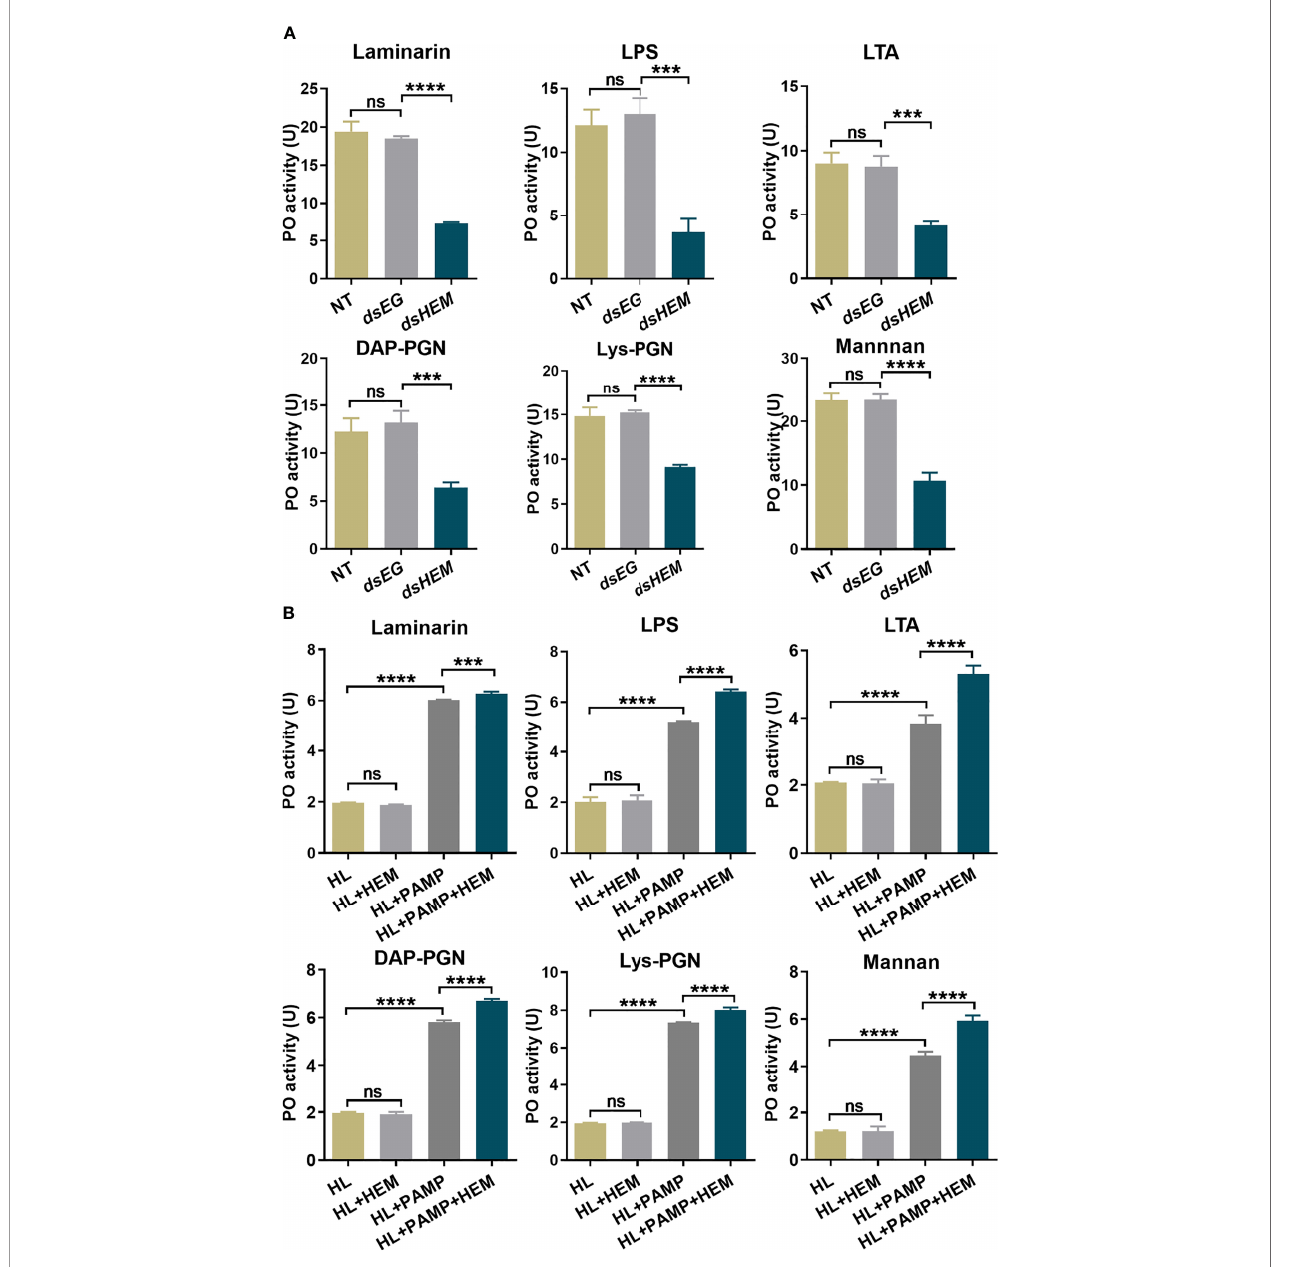
FIGURE 6 | PO activity assay stimulated by soluble PAMPs. The effects of endogenous (A) and exogenous (B) hemolin on PPO cascade activation by soluble PAMPs were investigated by monitoring the PO activity produced in the A. pernyi larval plasma as described in Figure 5 . PAMPs: laminarin (1 m g/ml), LPS (100 m g/ ml), LTA (100 m g/ml), DAP-PGN (500 m g/ml), Lys-PGN (500 m g/ml) and mannan (1 mg/ml). dsEG and dsHEM : plasma samples from dsEGFP - and dshemolin - injected 2 nd instar larvae, respectively; NT: nontreated 2 nd instar larvae plasma. HL: native cell-free hemolymph (total protein: 12 m g/ml); HEM: recombinant His 6 - Ap - hemolin (500 ng). Each bar represents the mean ± SD (N=3). ***: p<0.001, ****: p<0.0001, ns, no signi fi cant